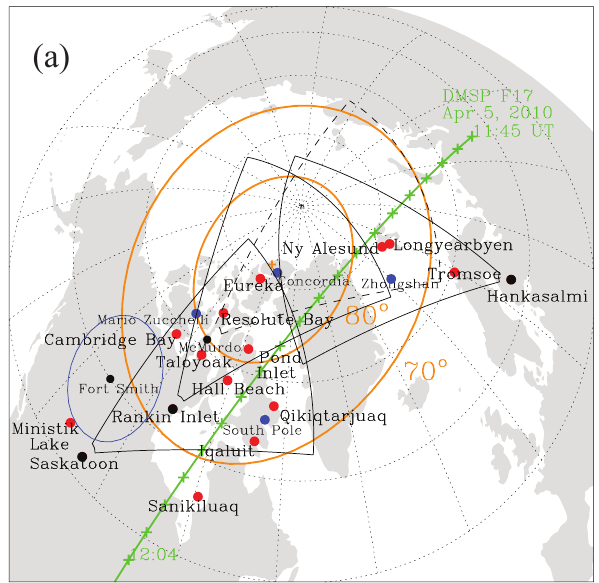
Fig. 1a. The CHAIN and European GISTM arrays (red dots) and fields of view of SuperDARN radars in Saskatoon, Rankin Inlet and Hankasalmi. Conjugate locations of four Antarctic GPS receivers (blue dots) and the field of view of the McMurdo SuperDARN radar (dashed line) are superposed. The location and field of view of an all-sky imager in Fort Smith is shown. Corrected geomagnetic (CGM) latitudes 70 ◦ N and 80 ◦ N and DMSP F17 satellite track are superposed.